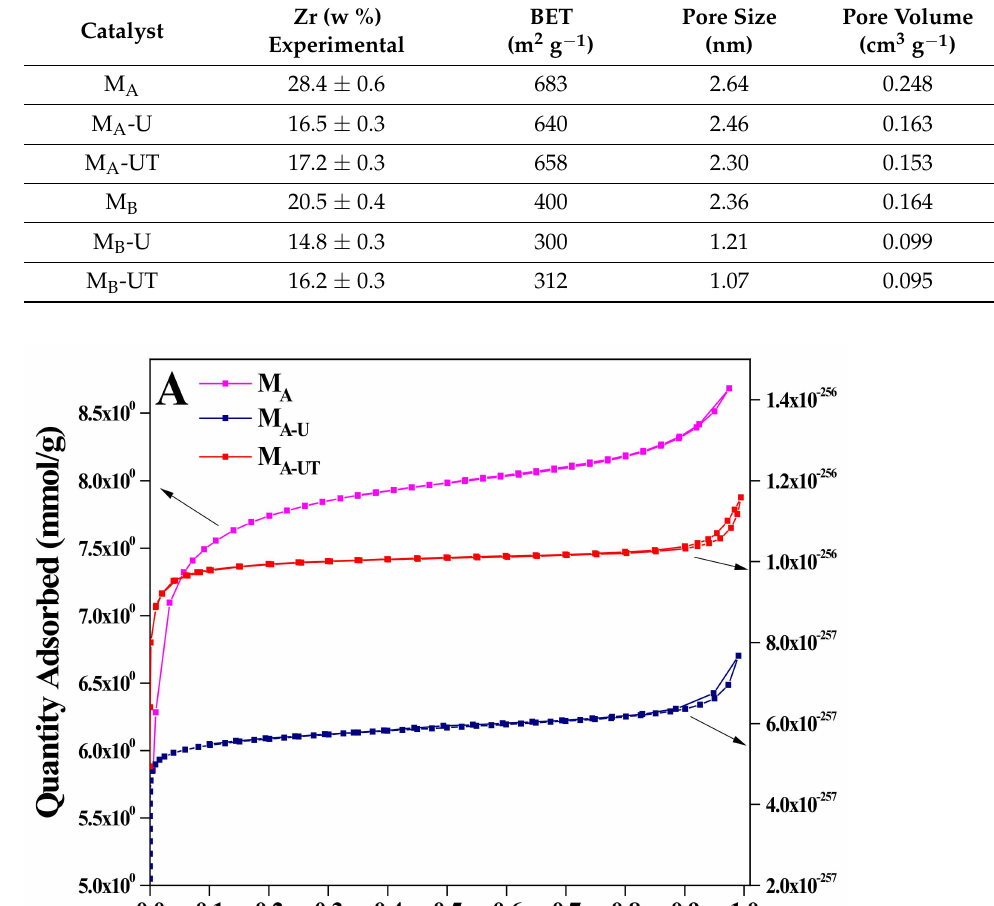
Table 1. Composition and surface analysis.